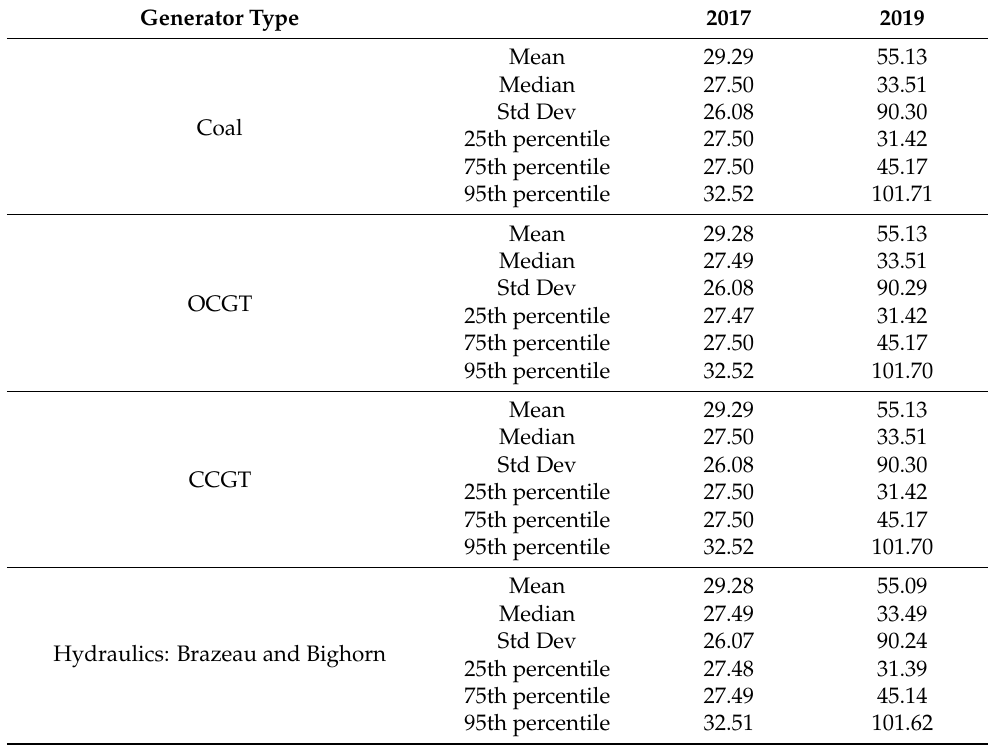
Table 4. Calibrated Marginal Costs